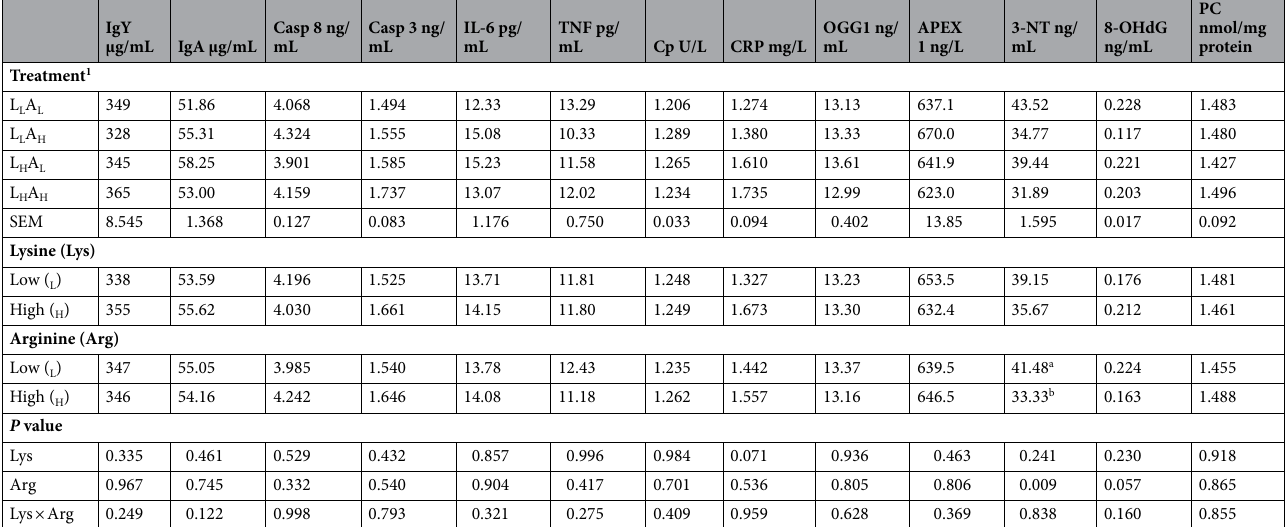
Table 3. Blood immunological and redox parameters of turkeys at 9 weeks of age. IgA: immunoglobulin A; IgY: immunoglobulin Y; Casp 3: caspase 3; Casp 8: caspase 8; IL-6: interleukin 6; TNF-α: tumor necrosis factor alpha; Cp: ceruloplasmin; CRP: C-reactive protein; OGG1: oxoguanine glycosylase; APEX-1: endonuclease 1; 3-NT: 3- nitrotyrosine; 8-OHdG: 8 - hydroxydeoxyguanosine; PC: protein carbonyl. 1 L L A L diet with low Lys and low Arg levels; L L A H diet with low Lys and high Arg levels; L H A L diet with high Lys and low Arg levels; L